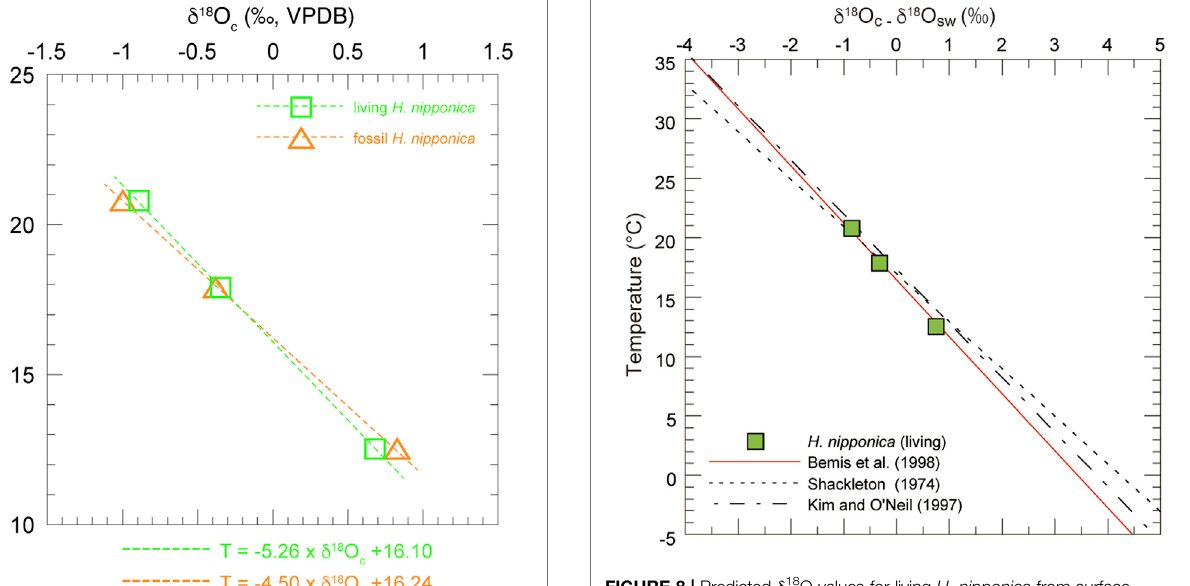
FIGURE 8 | Predicted δ 18 O values for living H. nipponica from surface sediments on the continental shelf in Tosa Bay. Published relations between temperature and δ 18 O are also plotted (Shackleton 1974; Kim and O ’ Neil 1997; Bemis et al., 1998). The H. nipponica data show a good fi t to the equation of Bemis et al.